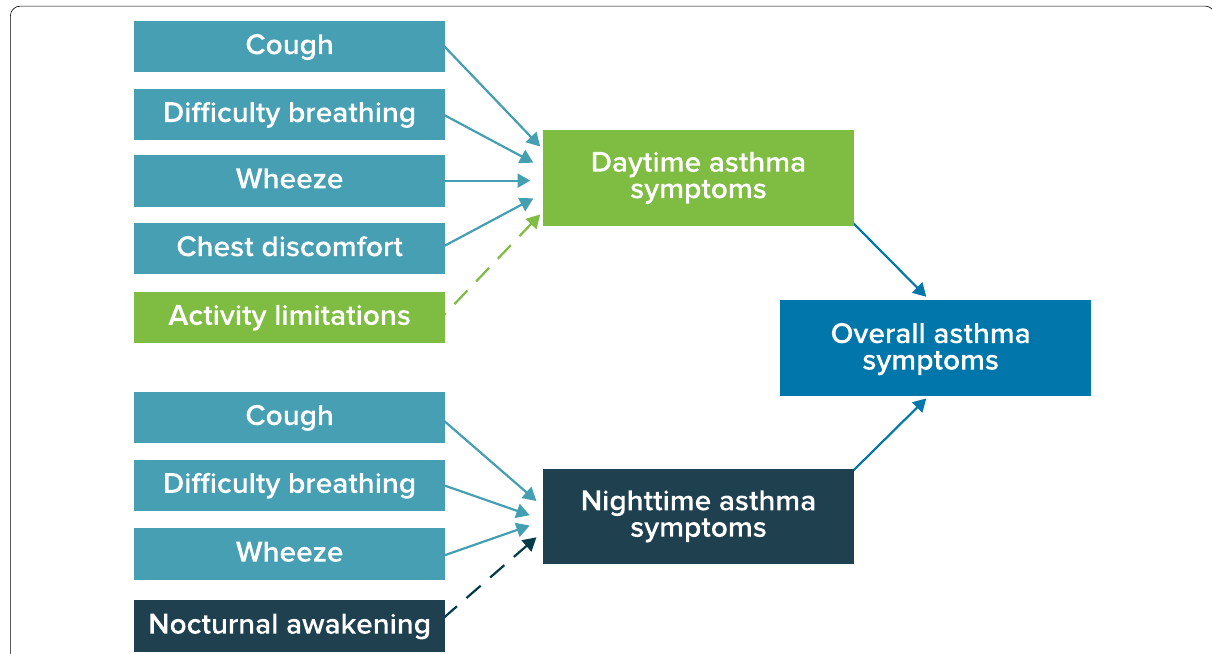
Fig. 2 ePASD draft conceptual framework. ePASD electronic Pediatric Asthma Symptom